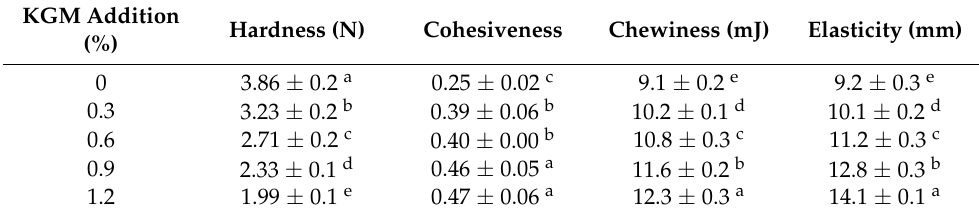
Table 3. Parameters of texture profile of CS/KGM